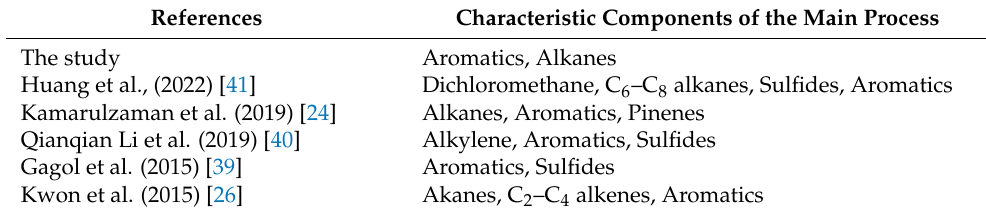
Table 3. Comparison of key VOCs components in other rubber